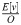
Step length, locality, and path.A: Mean step length over time for a wild-type N2 off food showcasing two distinct movement phases using different colors: the first phase (red) corresponds with “local” movement behavior with short step lengths. The second (blue) movement phase correspond with “global” movement behavior. B: Locality (E[v]O) through time. When step length is low, the locality is usually high and vice versa. C: A complete path of the observation period (colored corresponding to the phases described in A). D: Zoomed path sections corresponding to the phases described in A.